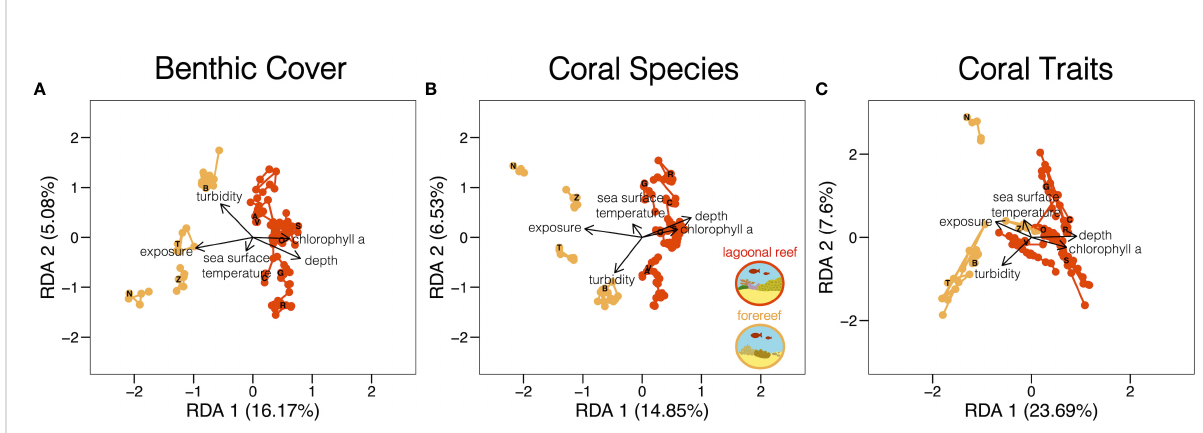
FIGURE 3 Environmental conditions that drive variation in reef community composition and function across space and time. Colouring within each RDA triplot differentiates lagoonal reef and forereef communities of benthic cover (A) , the coral species (B) , and coral traits (C) . Points represent each of 11 reef communities in Bocas del Toro every year of monitoring. Arrows show the loading of environmental variables that explain variation within and between reef communities. Letters represent reef locations and mark community composition in